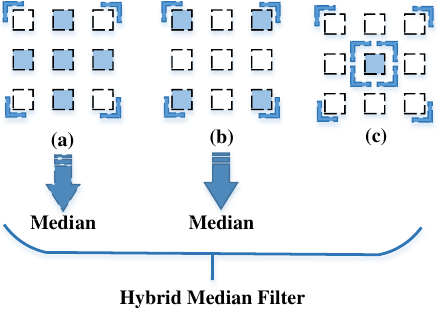
Fig. 3. (a) MF with cross mask, (b) MF with x mask and (c) Median of M P and M D .